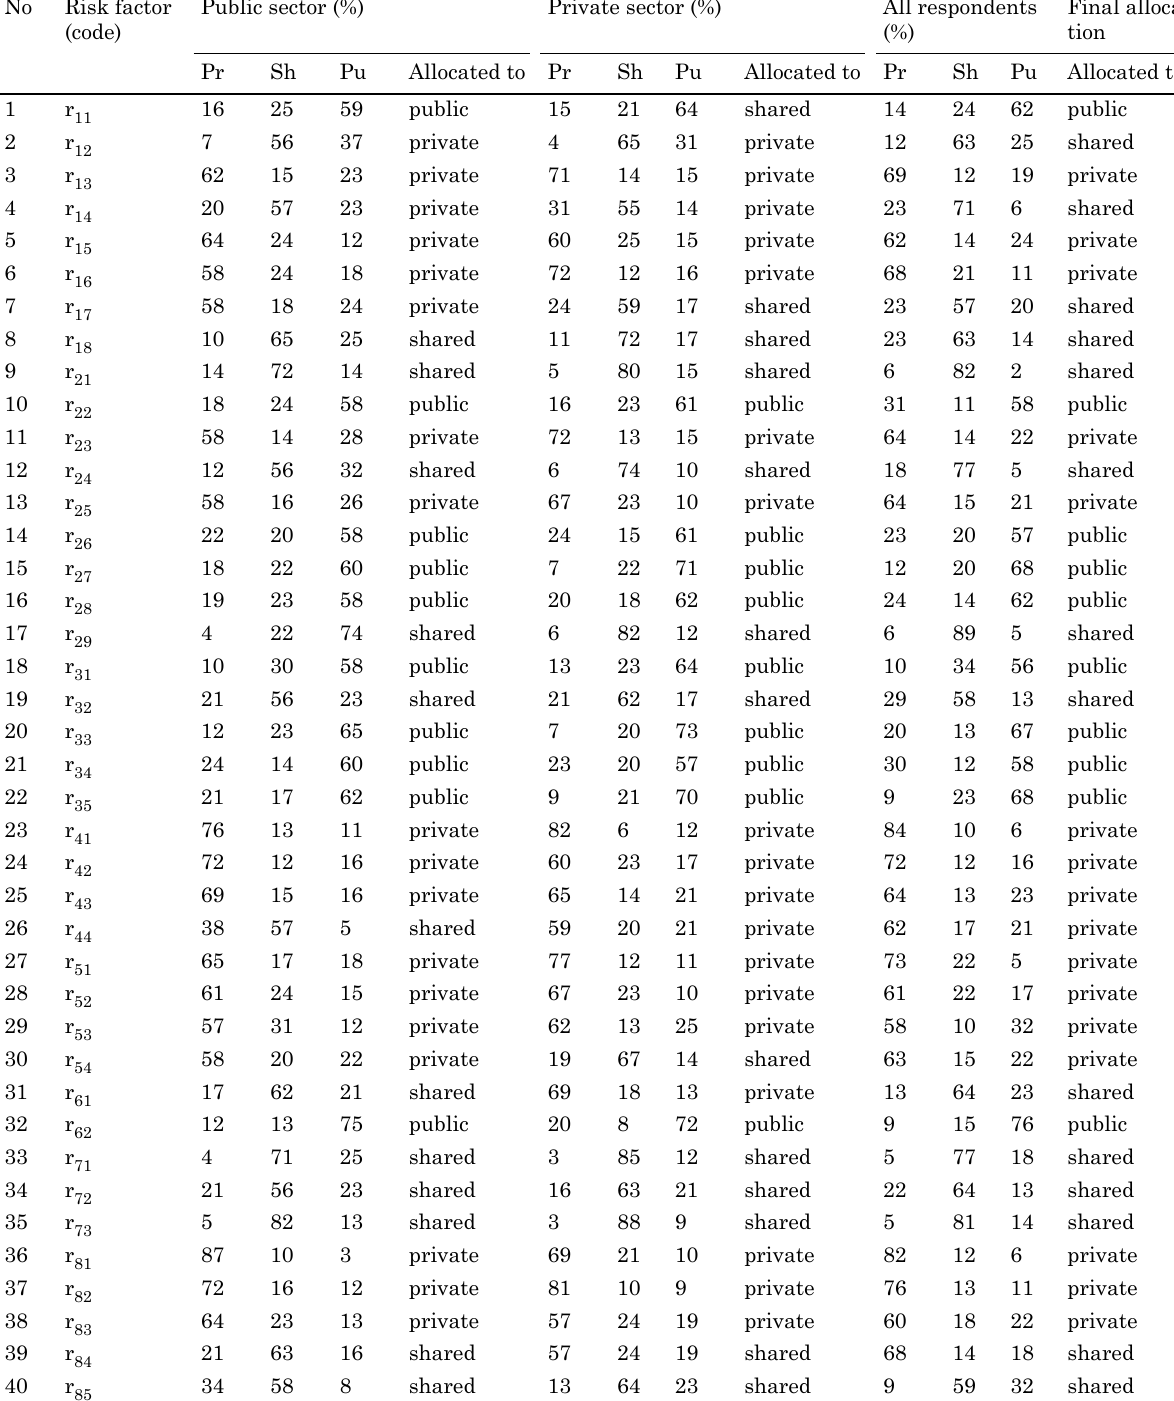
Table 11. Results of risk allocation in Iranian PPP